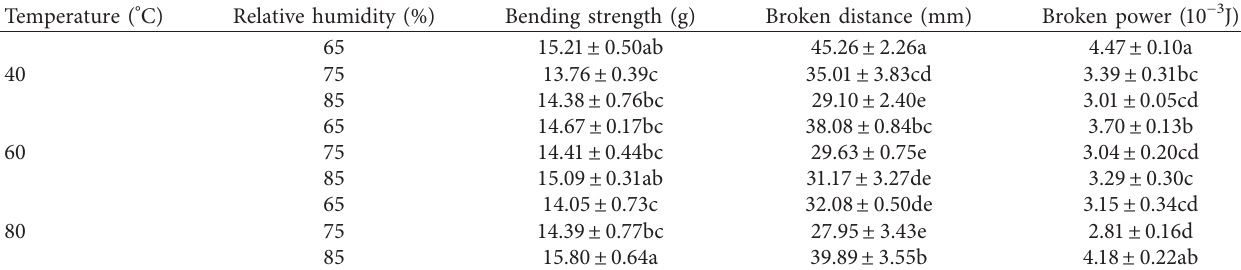
Table 2: Effects of drying temperature and relative humidity on TPA characteristics of uncooked